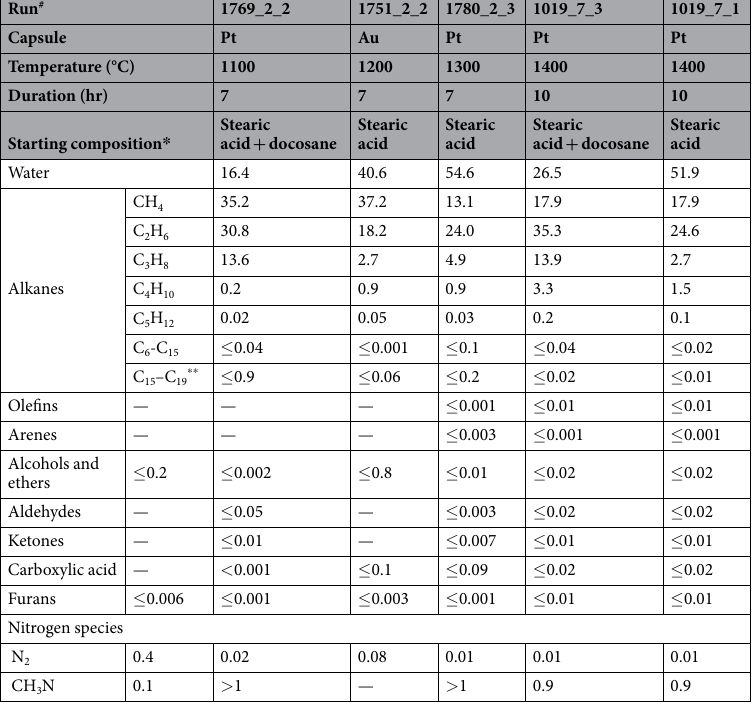
Table 5. Representative analyses of quenched H 2 O-rich C-O-H-N fluids (rel.%) obtained in runs at 6.3 GPa and 1100–1400 °C. * All samples contained graphite. ** The quoted concentrations are maximum for a species of the respective group. All GC-MS data are given in Supplementary Table